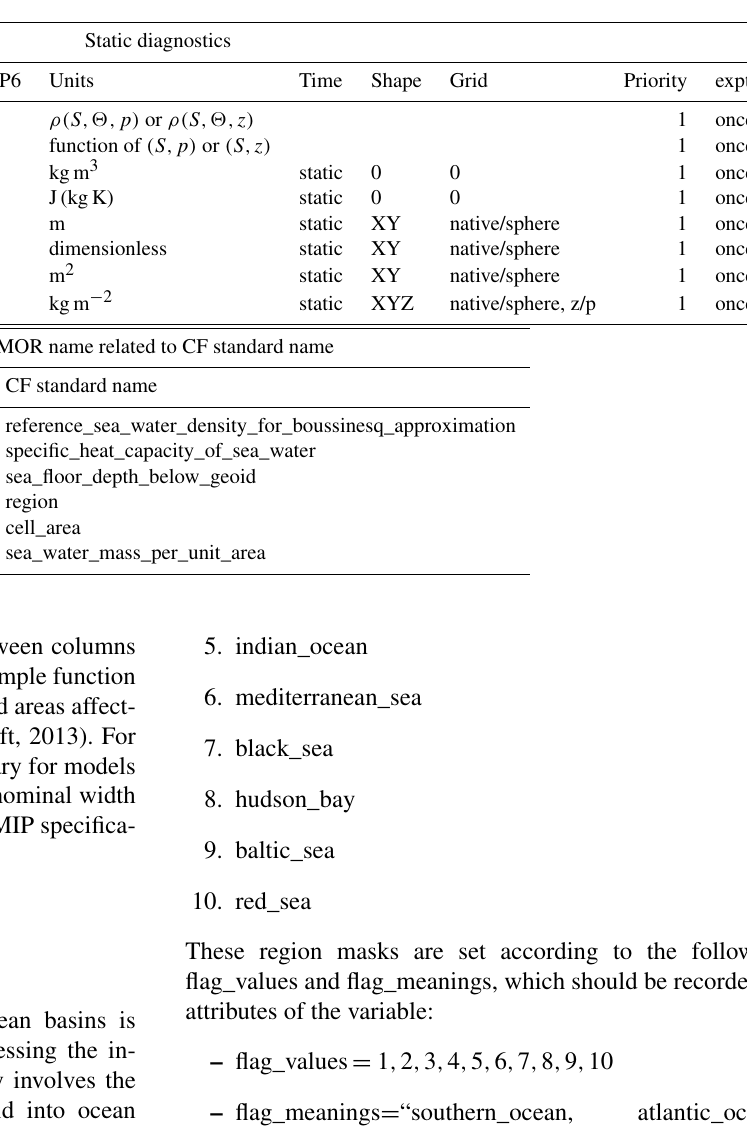
Table G1. Static fields and functions to be saved for the ocean model component in CMIP6, as well as how the CMOR name for a diagnostic is related to its CF standard name. These fields provide basic information about the model configuration, and need only be archived once for all the model experiments in the CMIP6 repository (hence the “once” entry for the experiment column). Blank entries signal a characteristic that is not applicable for this particular diagnostic. Furthermore, the bottom topography, grid length and areas, and basin regions should be made available on both the model native grid and on the spherical latitude–longitude grid onto which scalars are regridded. The entry for masscello applies only to Boussinesq models with static grid cell volumes (Appendix B). For other kinds of models, masscello is generally time-dependent and the entry in Table H1 applies